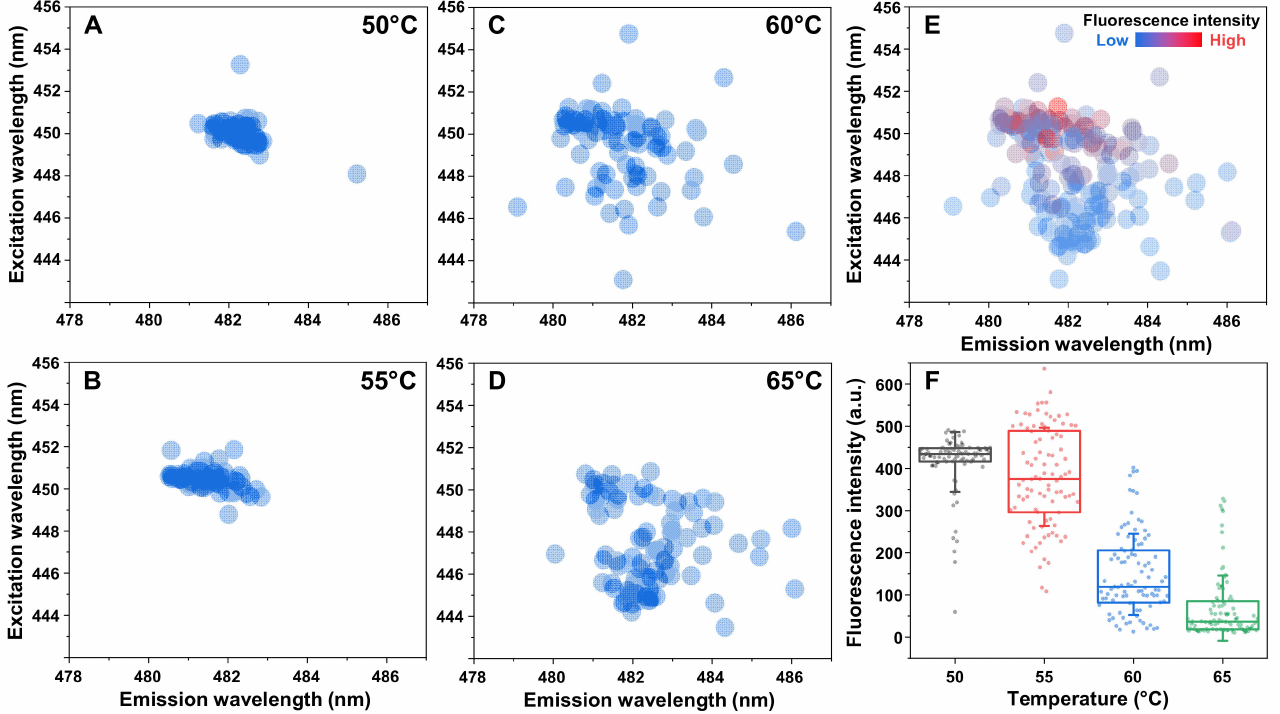
Figure 2. Correlation between sample fluorescence parameters and lysozyme aggregation tempera- tures. Bound ThT excitation-emission matrix (EEM) “center of mass“ positions of samples prepared under 50 ◦ C ( A ), 55 ◦ C ( B ), 60 ◦ C ( C ) and 65 ◦ C ( D ) conditions. EEM position and signal intensity correlation of 50 ◦ C and 65 ◦ C samples ( E ). Fluorescence intensity value distribution of samples prepared under different aggregation conditions ( F ). Box plots indicate the interquartile range and error bars are for one standard deviation. All data acquisition and analysis procedures are described in the Materials and Methods section. Raw data are available in the Supplementary